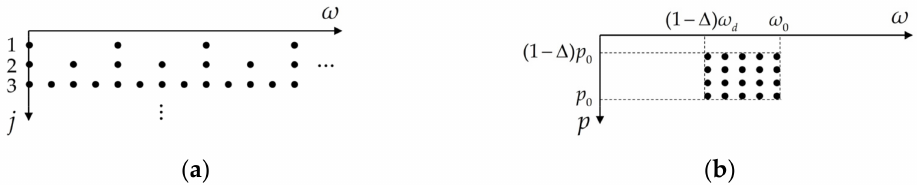
Figure 2. Spatial sampling of the frequency factor before ( a ) and after ( b )